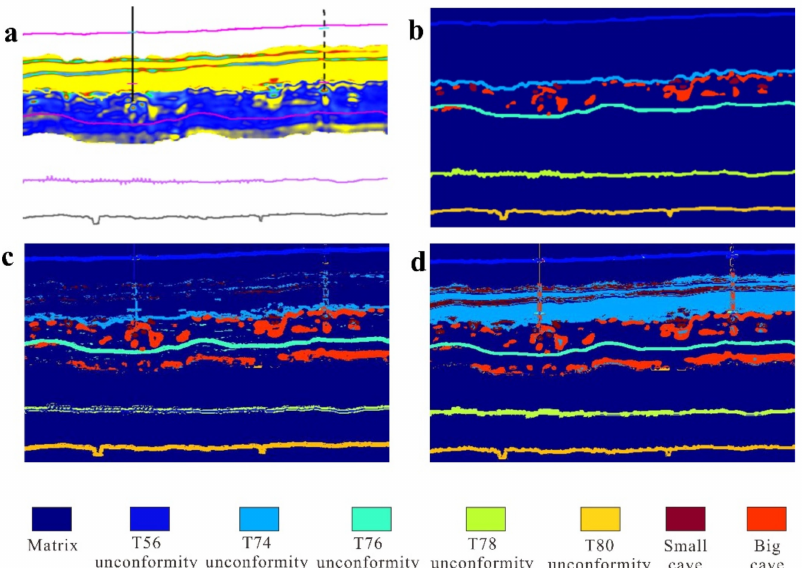
Figure 11. Comparison of the reference image 2550 ( b ) with the predicted images by LightGBM in cases A ( c ) and B ( d ) from image 2550 ( a